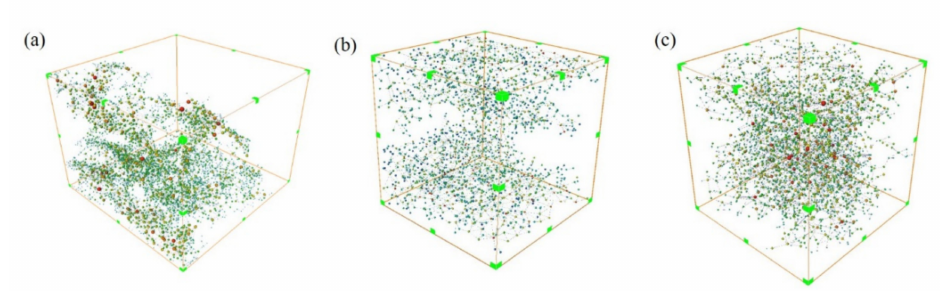
Figure 10. Pore network model of sample A ( a ), sample B ( b ), and sample C ( c